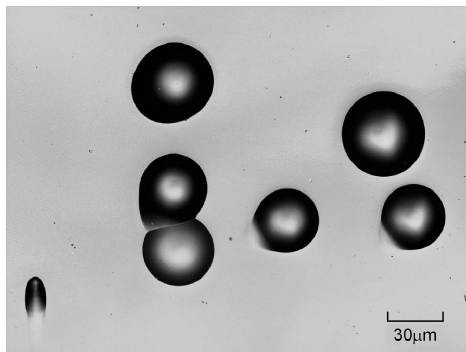
Fig. 3. Example using a × 100 objective of three coalescing tracks. were 51 clear single tracks, 8 double tracks (i.e. apparently consisting of two coalescing tracks) and 2 triple tracks (i.e.